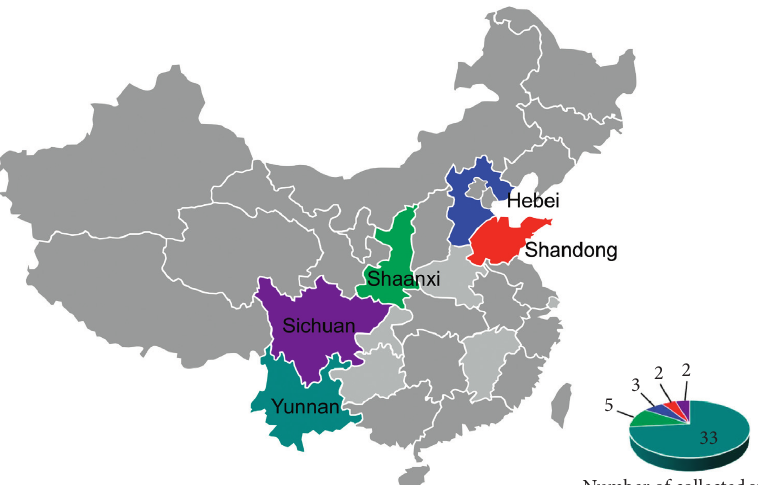
Figure 1: The walnut kernel samples collection from the main Chinese provinces for planting walnut. The inset pie chart displays the number of walnut types from the main five walnut-planting